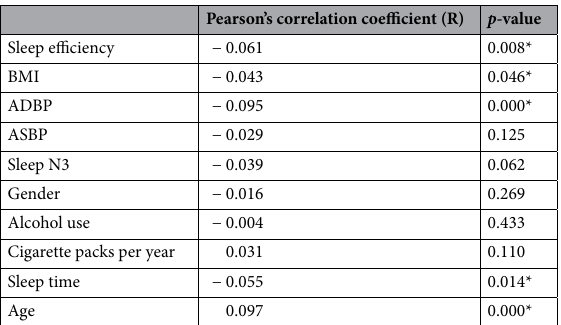
Table 5. Pearson’s coefficient of correlations (R) of different covariates with the number of angina episodes. BMI: body mass index; ADBP: average diastolic blood pressure; ASBP: average systolic blood pressure; Sleep N3: percent time in stage N3 of sleep. *Significant.